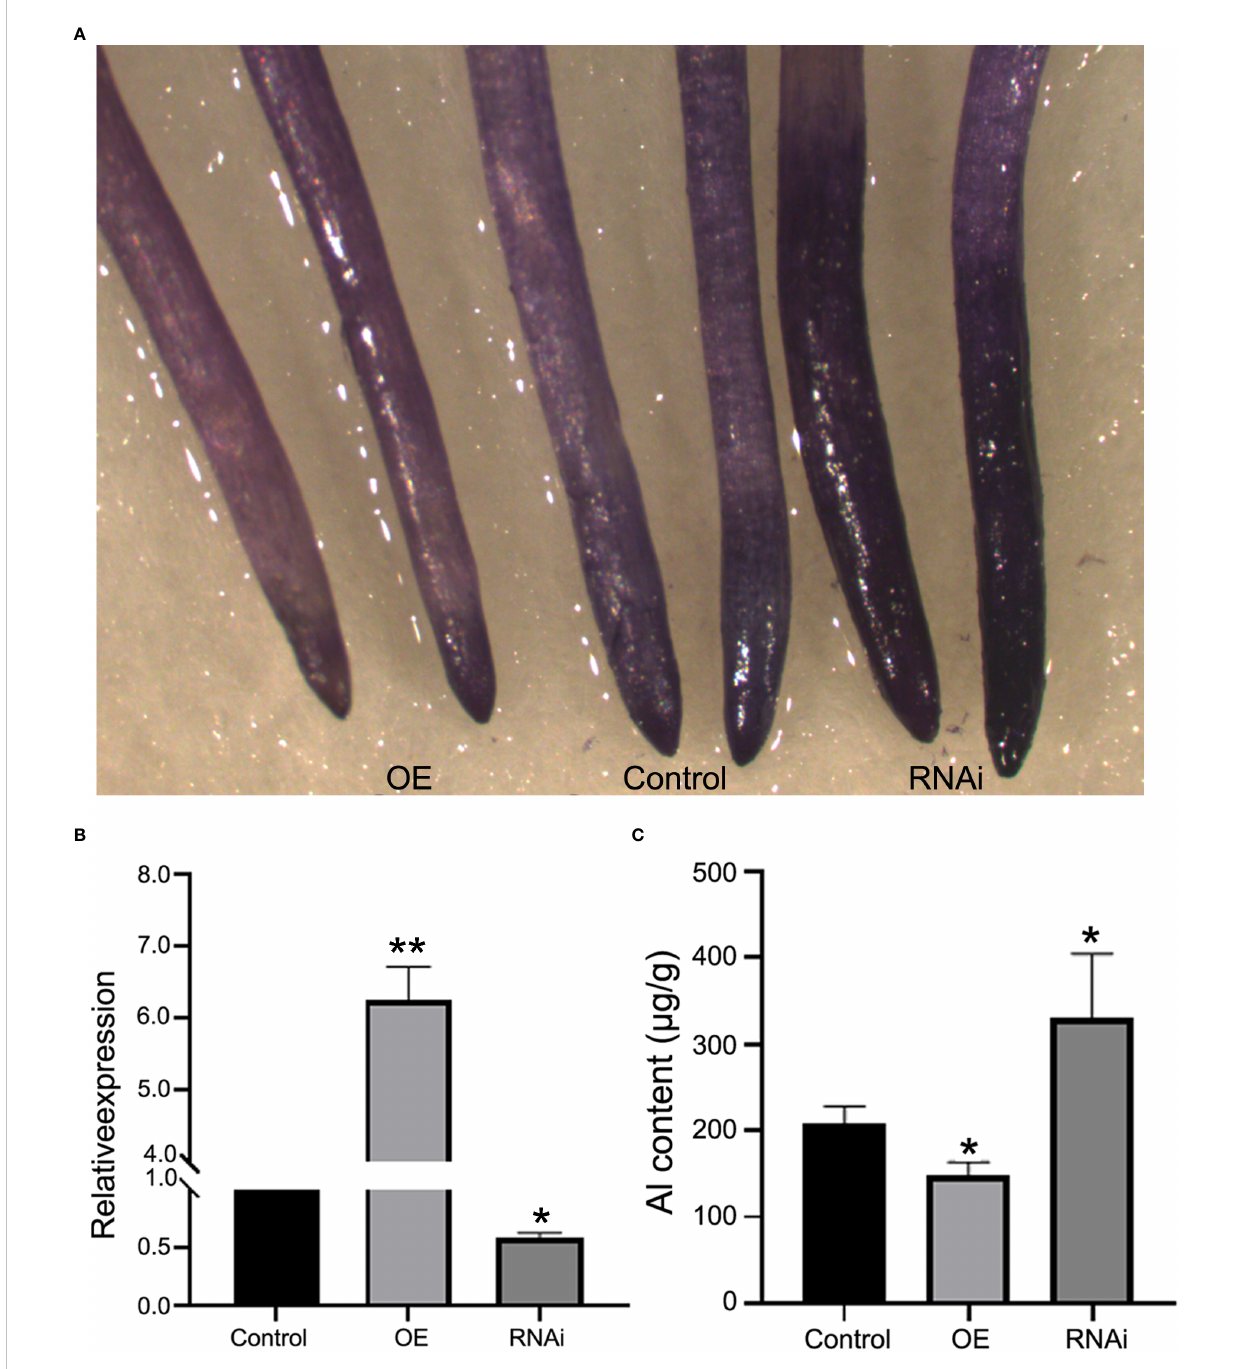
FIGURE 5 Soybean hairy roots experiment and hematoxylin staining. (A) Hematoxylin staining of soybean hairy roots. (B) Identi fi cation of RNA levels in hairy roots of soybean. (C) Determination of Al 3+ content in root tips of soybean hairy root lines. The asterisks in fi gure B and C indicate signi fi cant differences between WT and OE or RNAi lines ( *P < 0.05; **P < 0.01). Control: the lines of transformed pTF101 vector; OE: the lines of transformed pTF101-GmABR1 vector; RNAi: the lines of transformed pMU103-GmABR1